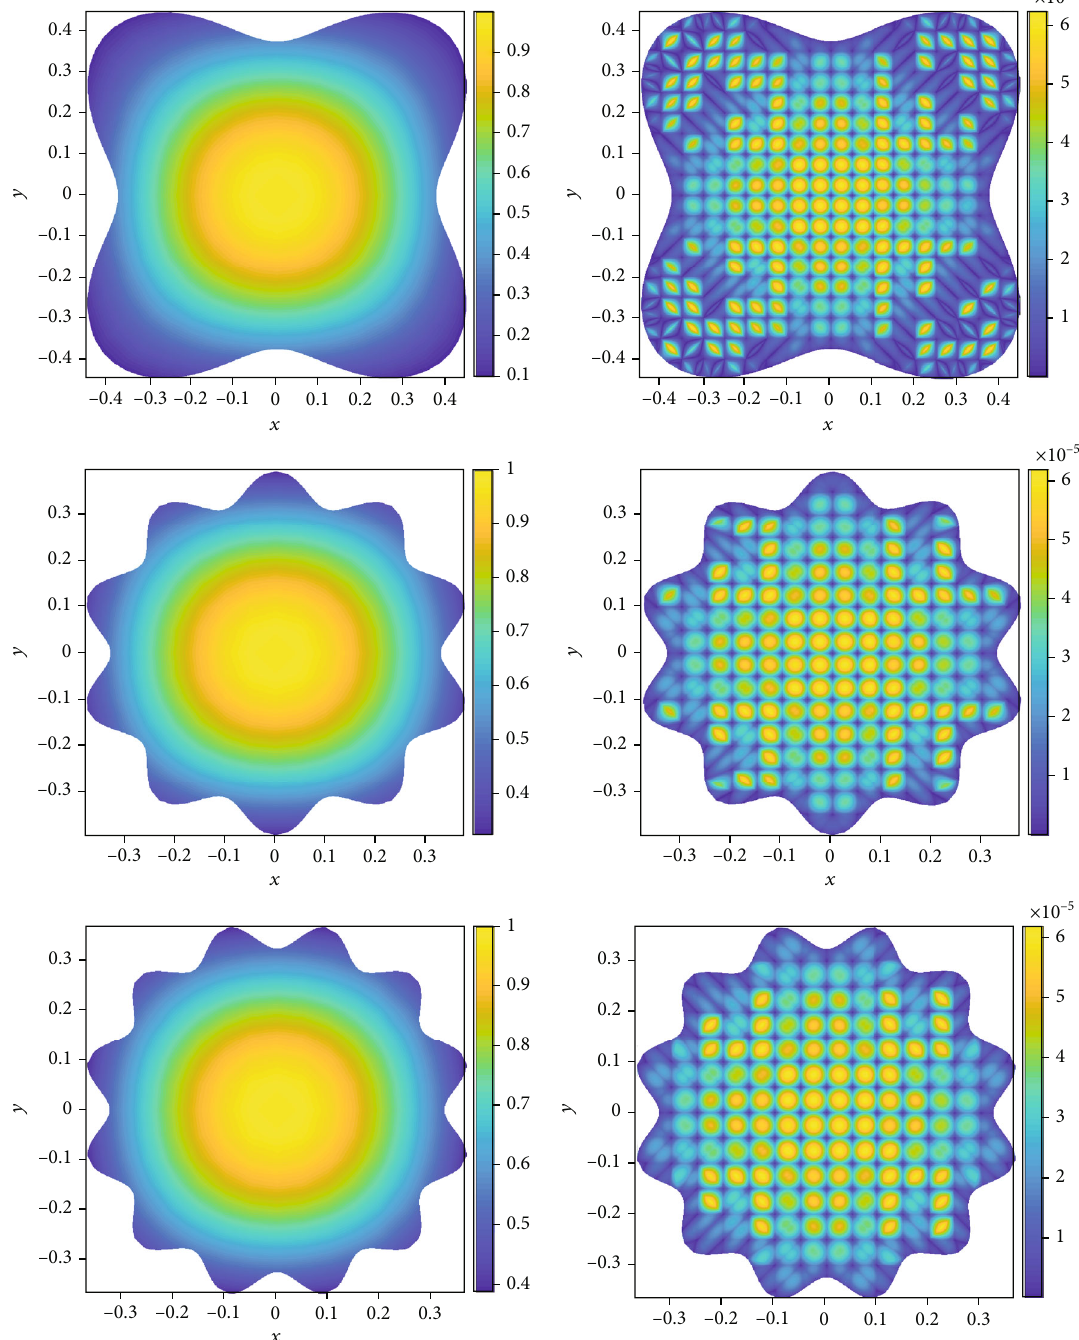
Figure 2: Approximate solution and its absolute error on irregular location points, ν = 1 : 1 , ν = 1 : 2 , ν = 1 : 9 , and di ff erent values of τ . Table 1 con fi rms that the theoretical order (TO) in tem- poral direction is near to the computational order, i.e., 3 − ν . Figure 1 demonstrates the approximate solutions (a) and its absolute errors (b) on square domains ½ 0, 1 (cid:2) × ½ 0, 1 (cid:2) (top fi gures), ½ 0, 4 (cid:2) × ½ 0, 4 (cid:2) (middle fi gures), and ½ 0, 8 (cid:2) × ½ 0, 8 (cid:2) (bottom fi gures) with τ = 0 : 001 , ν = 1 : 5 , and also 1000